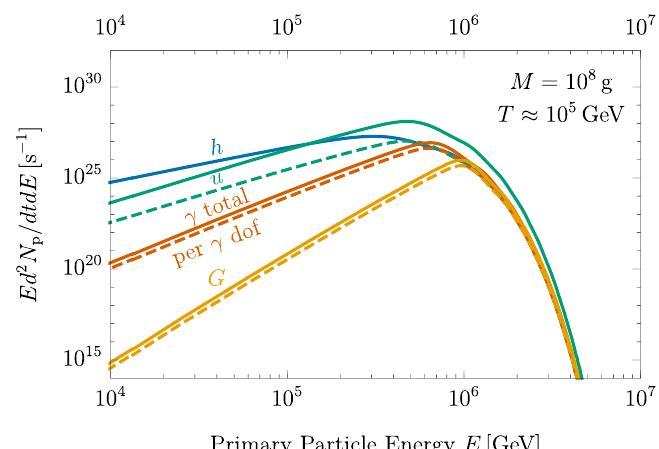
Figure 1 . Representative primary spectra for particles of spin 0 (the Higgs boson, h ), spin 1 / 2 (the up quark, u ), spin 1 (the photon, γ ) and spin 2 (the graviton, G ) for a black hole of mass 10 8 g. The dashed lines show the spectra per degree of freedom while the solid lines include the factors